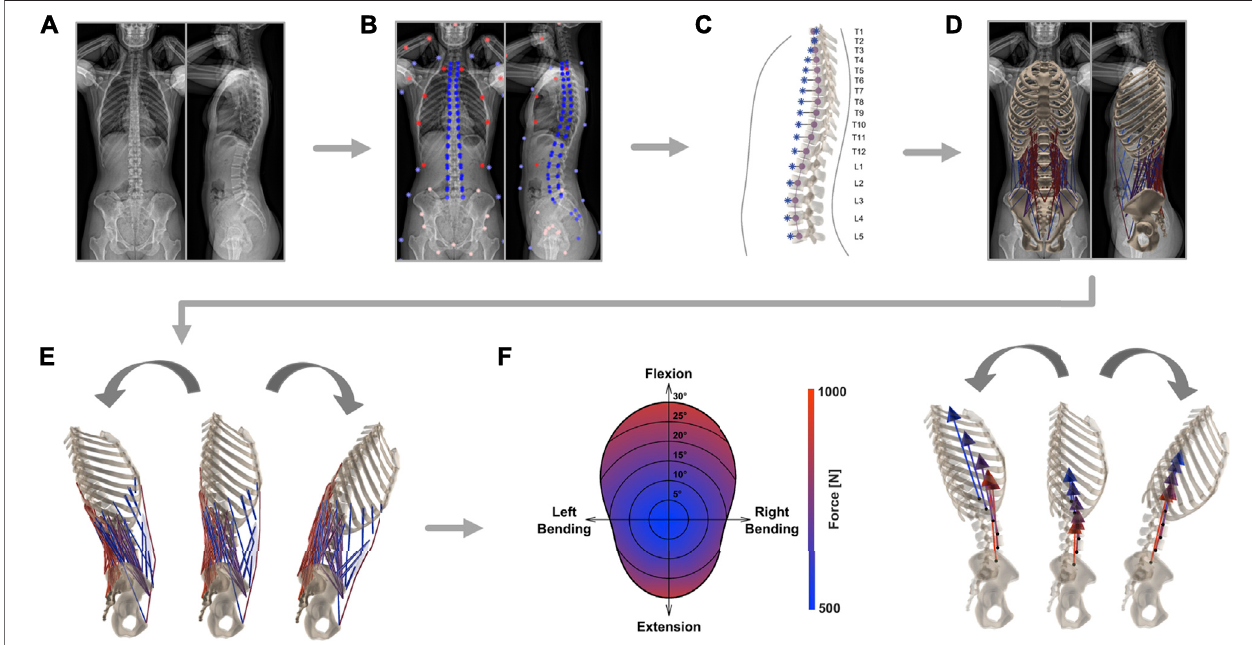
FIGURE 1 | Schematic depiction of the steps required for the generation of individualized musculoskeletal models. After EOS image acquisition (A) , the bi-planar radiographs were annotated by an experienced medical professional (B) . From the resulting landmarks, the alignment of the thoracolumbar spine (purple) and the segment-wise position of the center of mass (blue) were derived (C) . A model rendering subject anatomy was created and included the eight major muscle groups involvedinstabilizingthelowerspine (D) .Kinematicboundaryconditionswereset (E) andconsequentlymagnitudeanddirectionofjointloadwascomputedbased on static optimization (F)